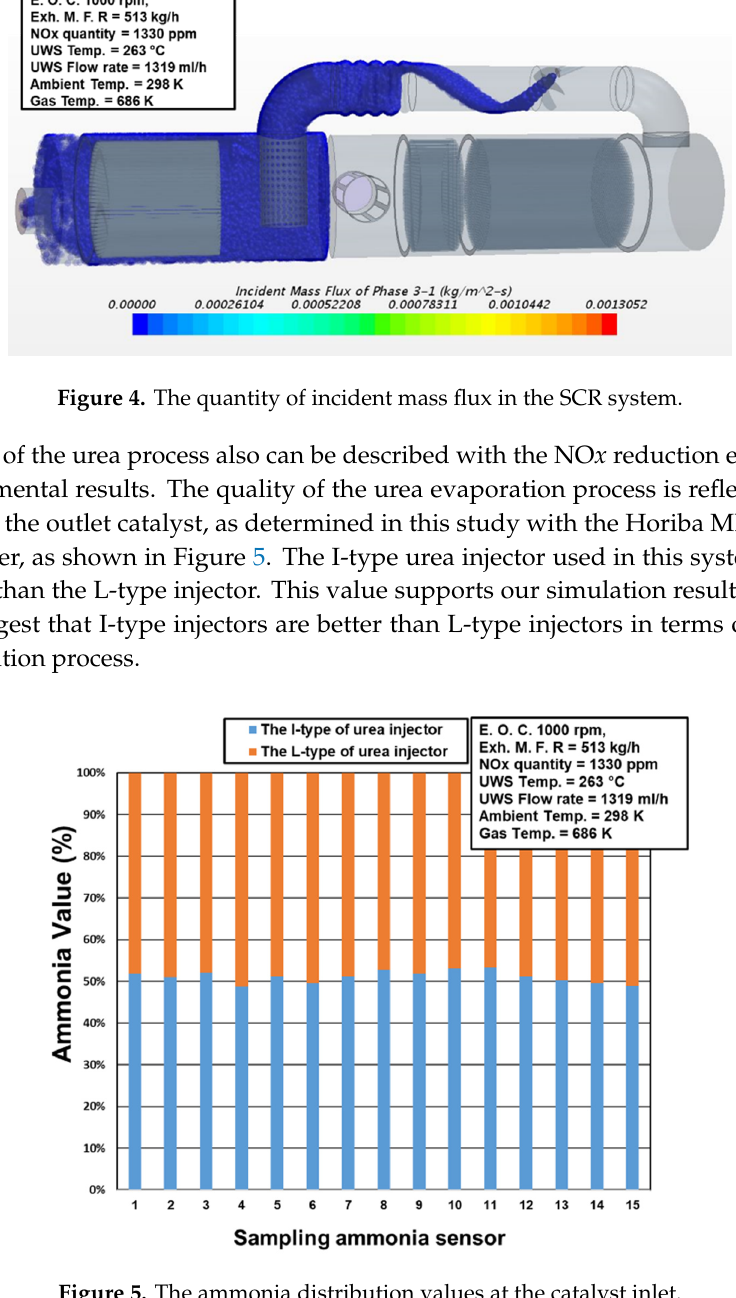
Figure 5. The ammonia distribution values at the catalyst inlet.